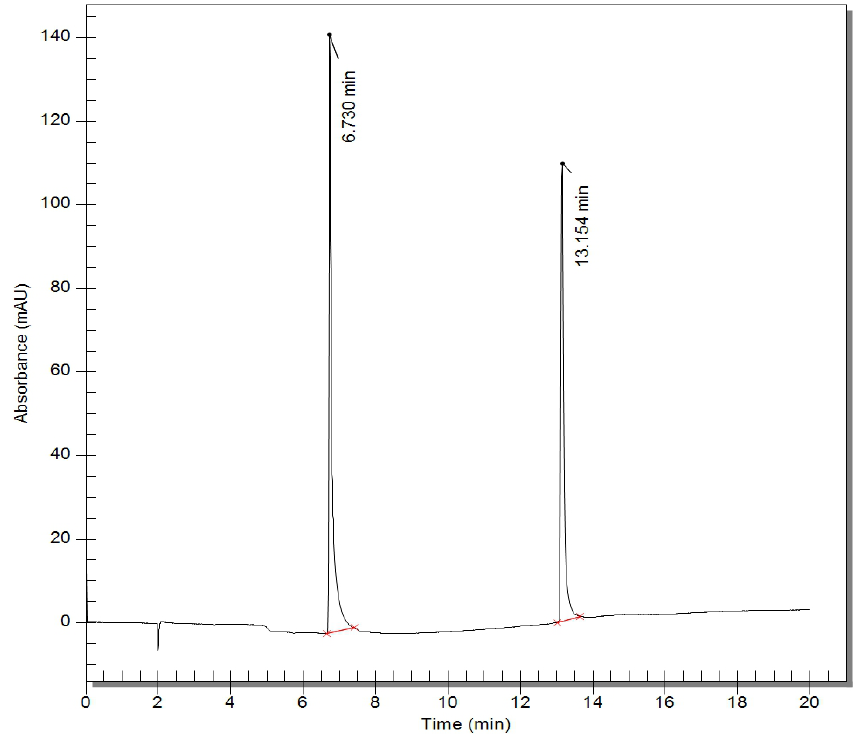
Figure 2. Chromatogram of plasma sample from rats following intravenous (i.v.) administration of 10 mg/kg of BHMC showed good resolution of internal standard and BHMC with no interfering peak around the retention time of internal standard at 6–7 min and BHMC at 13–14 min.